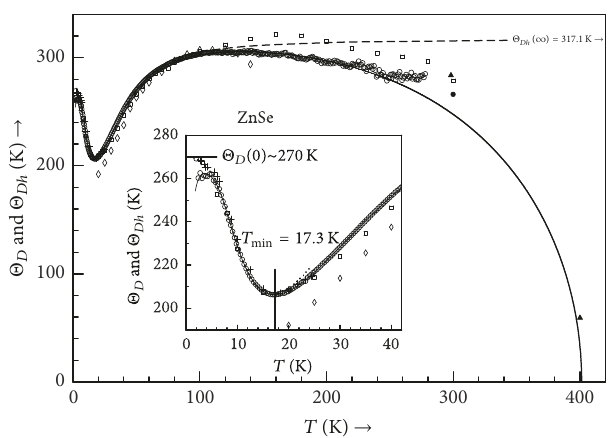
Figure 4: Effective Debye temperature values, Θ 𝐷 (𝑇) , as resulting for ZnSe from measured (isobaric) heat capacities, 𝐶 𝑝 (𝑇) ([46] ( I ), [34] (+), [10] ( ◊ ), [79] ( ◻ ), [80] ( e ), and [78] ( 󳵳 )). The continuous curve for the true Debye temperature, Θ 𝐷ℎ (𝑇) (–– –––), is due to (28) in combination with (9) for the isochoric (harmonic) heat capacity shape function, 𝜅 ℎ (𝑇) ≡ 𝐶 𝑉ℎ (𝑇)/6𝑅 (according to the parameters listed in Table 1). The continuous curve for the effective Debye temperature, Θ 𝐷 (𝑇) (solid curve), is due to (27) and (28) in combination with (5) and (9) for the associated isobaric (anharmonic) heat capacity shape function, 𝜅(𝑇) ≡ 𝐶 𝑝 (𝑇)/6𝑅 . The dotted curve (in the inset) shows the low-temperature dependence of the true Debye temperature, Θ 𝐷ℎ (𝑇) , according to (30).